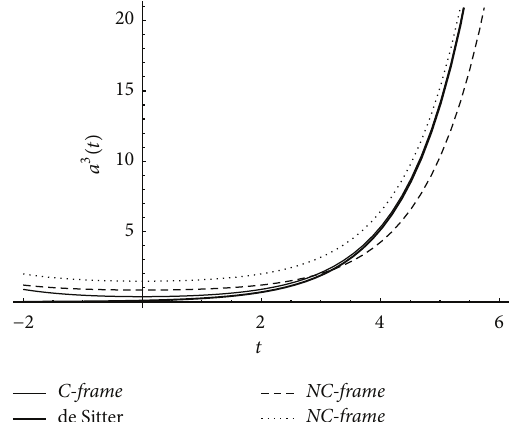
Figure 1: Dynamics of the deformed phase space model for 𝜔 󸀠2 > 0 . In all the plots of the deformed model, 𝛿 2 = 𝛿 1 = 0 . The thin line and dashed lines are for 𝜂 0 = 𝜁 0 = 1 , 𝛽 = 1, 𝜔 = 0 , and 𝜃 = 5 ; the dotted line is for 𝜂 0 = 5/8 , 𝜁 0 = 4 , 𝜃 = 4 √ 6/5 , 𝜔 = 1 , and 𝛽 = 1/ √ 5 . Finally the thick line corresponds to the volume of the de Sitter space time. We can see that for large values of 𝑡 the behaviour is exponential.